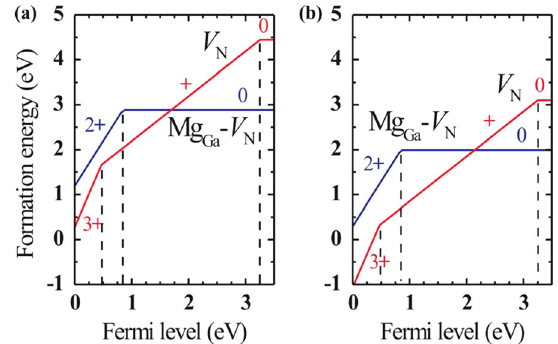
Fig. 6 Formation energy plots of V N and the Mg Ga - V N complex for a N-poor and b N-rich conditions. Reprinted from Ref. 76 with the permission of AIP